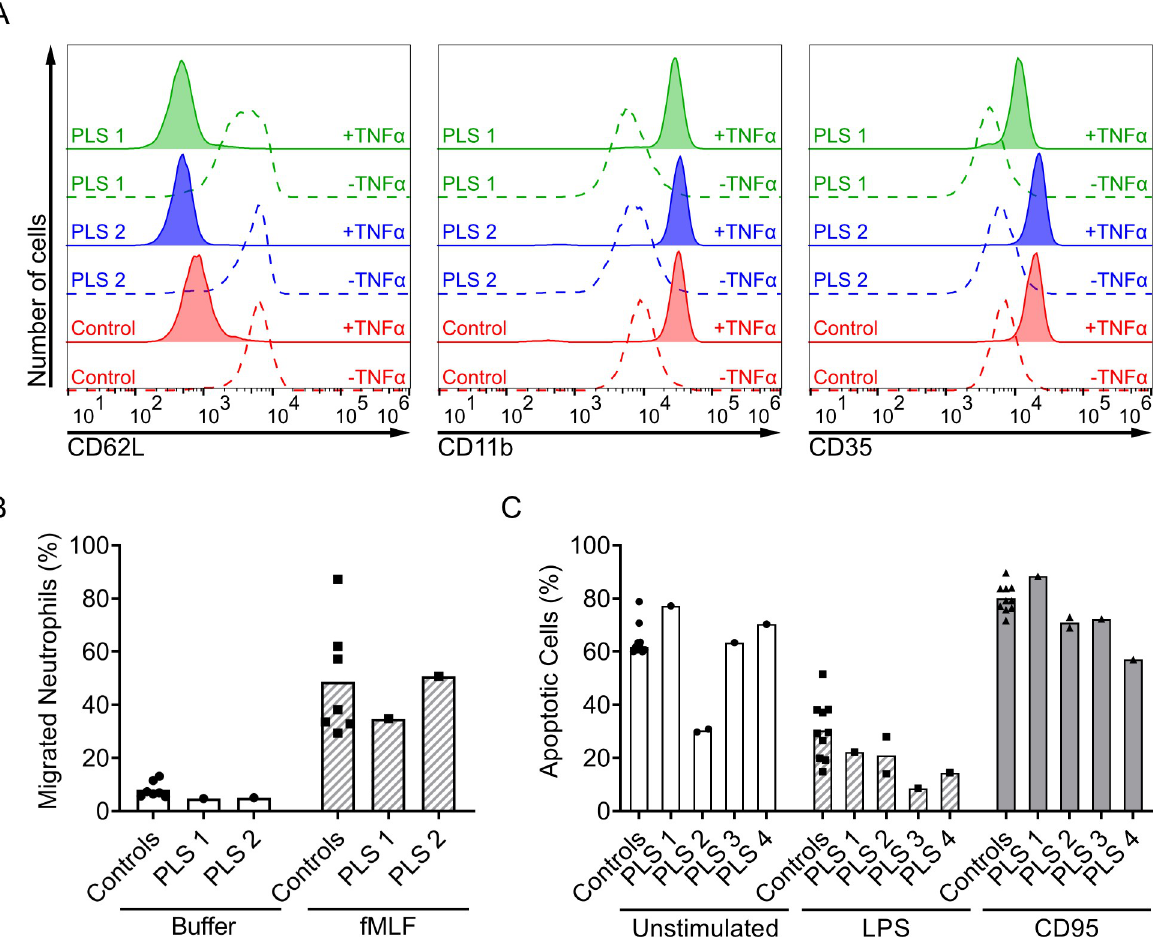
Fig 5. Activation of neutrophils in whole blood samples, chemotaxis of neutrophils and apoptosis regulation of neutrophils. (A) Histograms of flow cytometry analysis showing the ability of the neutrophils to regulate the surface marker expression during activation. Results shown are from the patients of family A (PLS 1 & 2) and one representative healthy control. Neutrophils were left unstimulated or activated with TNF α (10 ng/ml) for 20 min at 37˚C and labelled for extracellular markers CD62L, CD11b and CD35. (B) Bar diagram summarizing the migration for family A and healthy controls (n = 7). Isolated neutrophils were allowed to migrate through a polycarbonate chemotaxis membrane with a pore size of 3 μ m towards buffer or fMLF (10 nM) for 90 min at 37˚C, 5% CO 2 . The migrated cells were lysed, and the number of cells calculated by measuring the total amount of MPO-activity per well relative to a well corresponding to the total amount of cells. (C) Diagram showing the percentage of apoptotic cells after incubation with indicated stimulus for patients of family A (experiment for PLS 2 performed twice on different occasions), family B, and healthy controls (n = 10). Isolated neutrophils were placed in cell-culture buffer substituted with anti-apoptotic LPS, pro-apoptotic CD95 or left unstimulated for 20 h of incubation at 37˚C, 5% CO 2 before measurement by flow cytometry. Cells that stained positive for Annexin- V but negative for 7-AAD were classified as